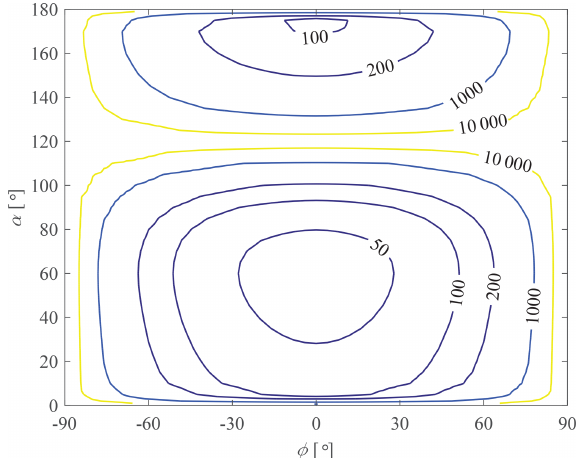
Figure 9. Distribution of maximum